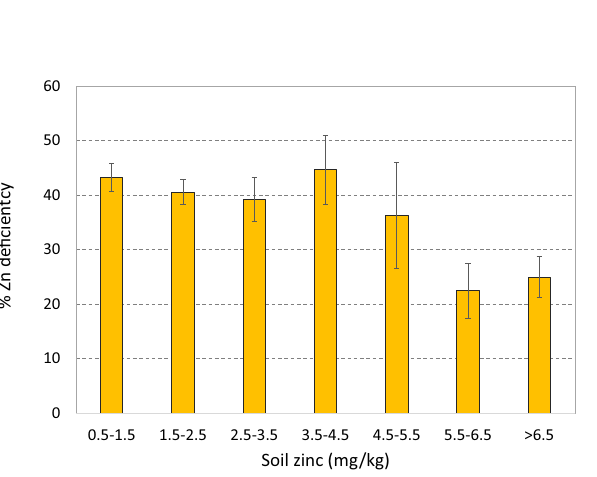
Table 1. Regression of serum zinc and zinc deficiency of children on soil zinc (all models estimated with random effects of the cluster variable, the 247 enumeration areas of the ENMS).